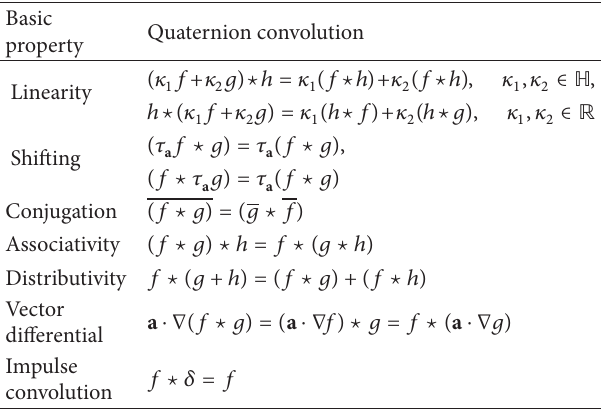
Table 1: Basic properties of quaternion